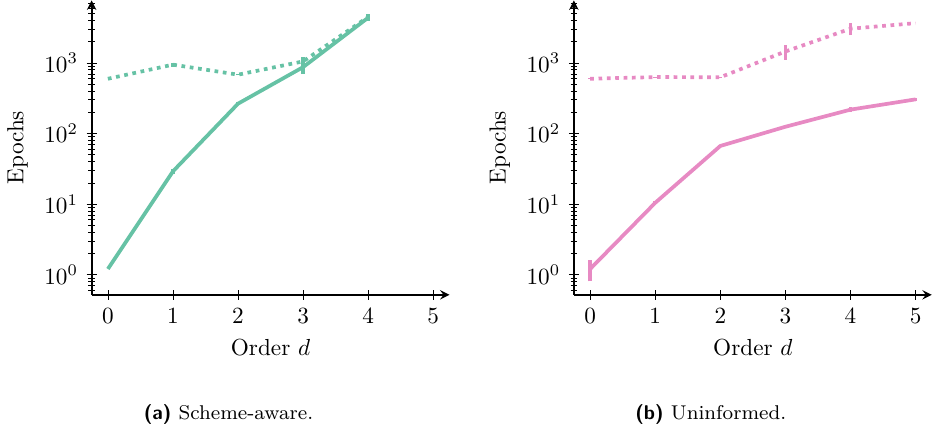
Figure 9: Number of epochs to get weak (plain curves) and strong (dotted curves) learning. plain curve goes from 1 epoch for d = 0 to 4 , 000 epochs for d = 4. This denotes an exponential increase of the optimization complexity in weak learning with the masking order. Since the optimization complexity in strong learning (denoted by the dotted curves) is strictly higher than the one in weak learning, we can also deduce that the optimization complexity in strong learning will follow an exponential